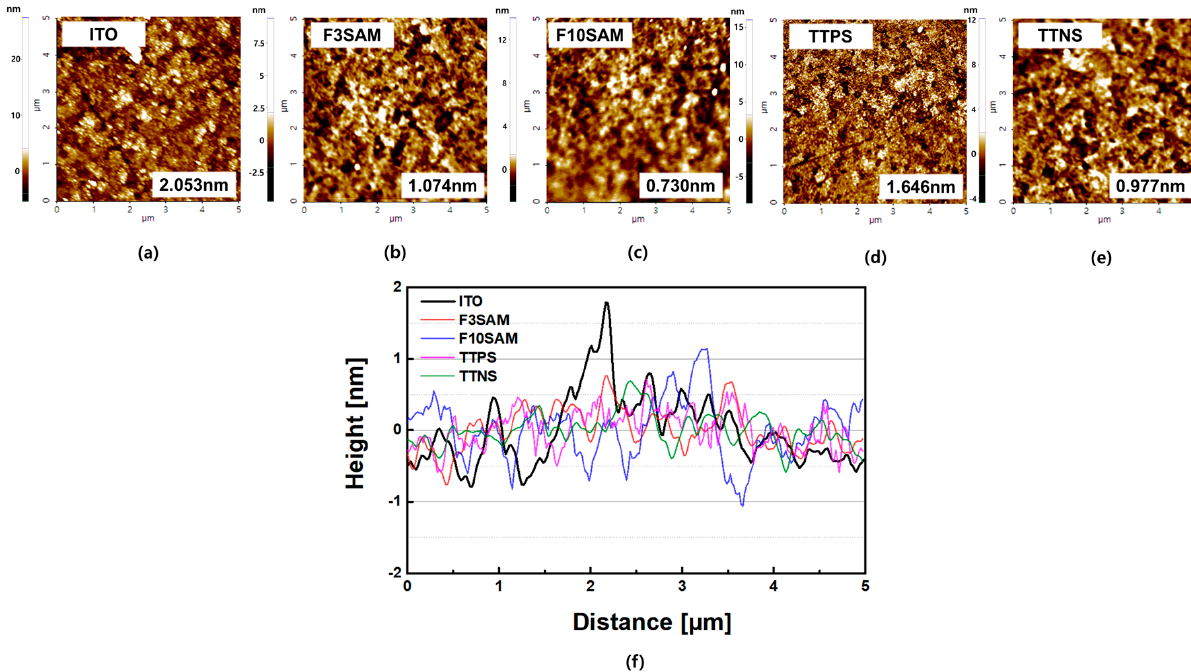
Figure 4. AFM measurements of SAMs on ITO: ( a ) ITO, ( b ) F3SAM, ( c ) F10SAM, ( d ) TTPS, ( e ) TTNS, ( f ) SAM roughness.